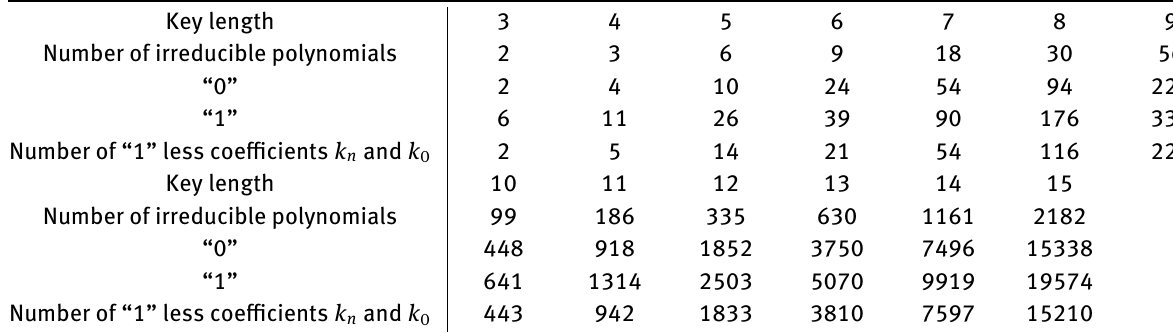
Table 6: Numbers of zeroes (“0 ′′ ) and ones (“1 ′′ ) in coeflcients of irreducible polynomials Key